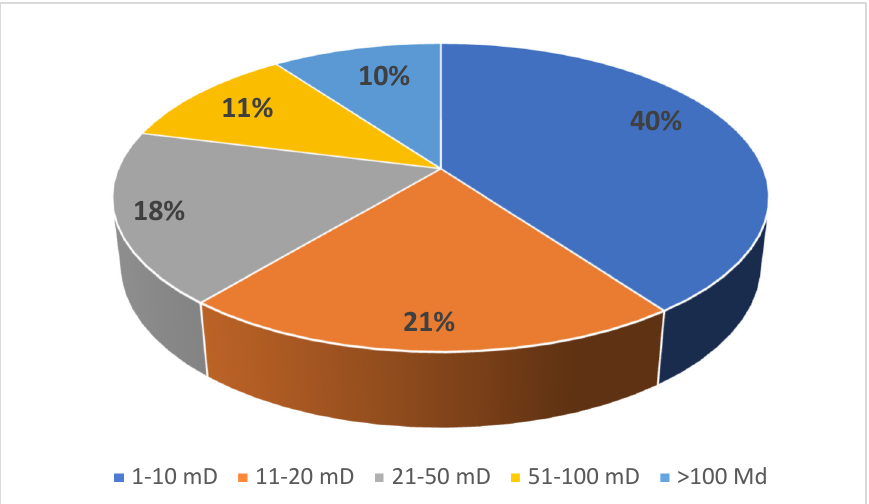
Figure 3. Permeability distribution of marginal resources in the studied oilfield.